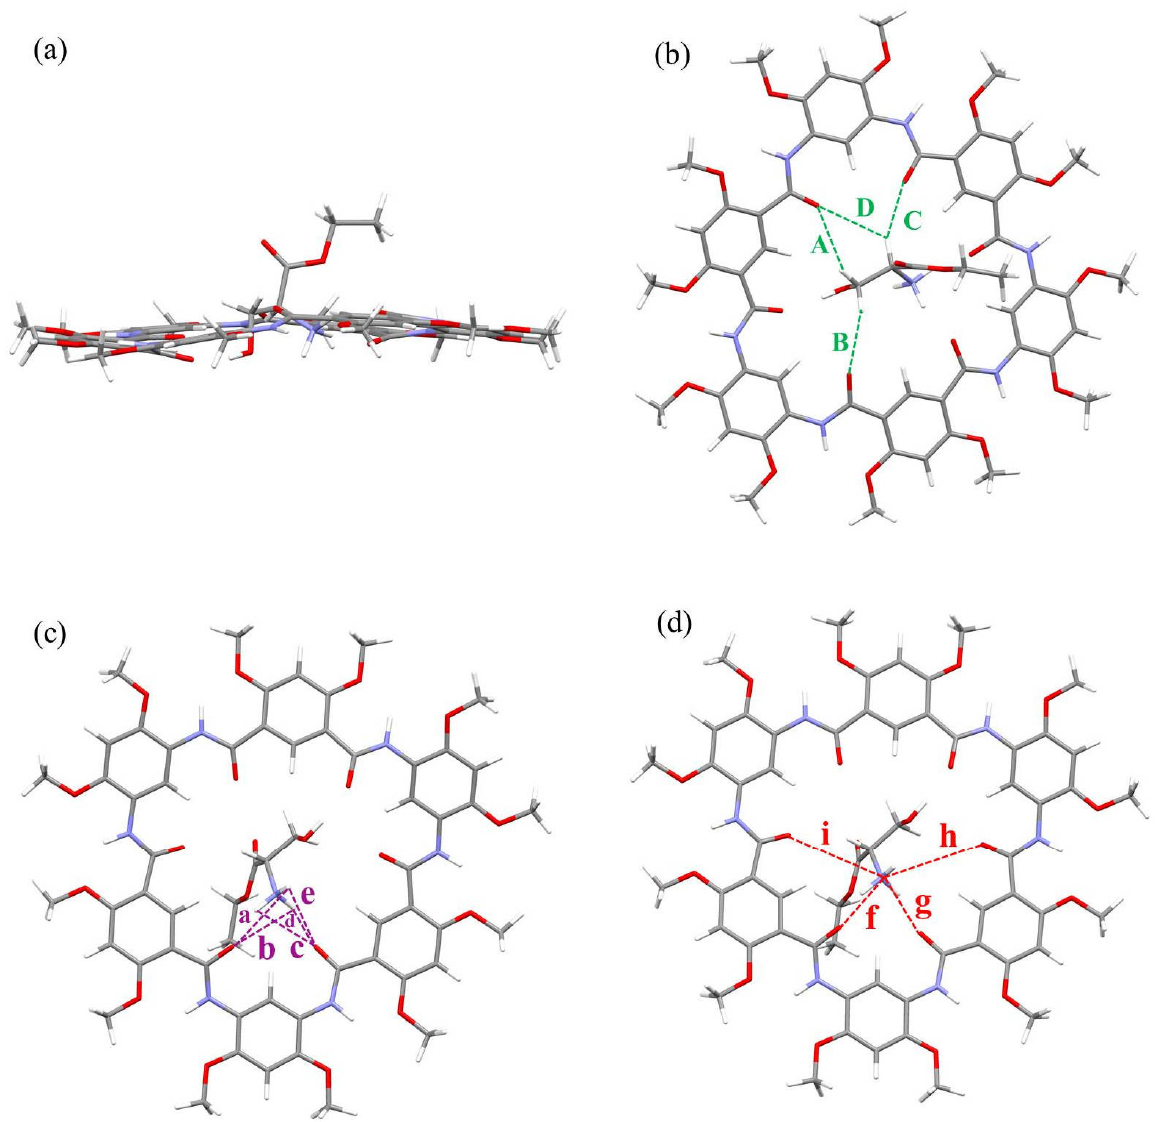
Figure 3. Side view ( a ) and top views ( b – d ) of optimized geometry of complex 1b ⊃ L1 at the B3LYP/6-311G (d, p) level (gray = C, white = H, red = O and blue = N). All side chains have been replaced by methyl groups for simplicity, and the counterion tetrakis (3,5-bis(trifluoromethyl)phenyl) borate anion (BArF − ) is omitted for clarity. The green dashed lines indicate C-H ∙∙∙ O hydrogen bonds A–D, where A = 2.851 Å (121.95°), B = 2.628 Å (140.95°), C = 2.446 Å (145.52°), D = 3.108 Å (123.54°). The purple dashed lines indicate N-H ∙∙∙ O hydrogen bonds a–e, where a = 3.274 Å (52.99°), b = 3.058 Å (64.77°), c = 3.047 Å (68.12°), d = 1.862 Å (154.20°), e = 3.241 Å (57.73°). The red dashed lines indicate N + ∙∙∙ O cation–dipole interactions f–i, where f = 2.779 Å, g = 2.829 Å, h = 4.554 Å and i = 4.151 Å.